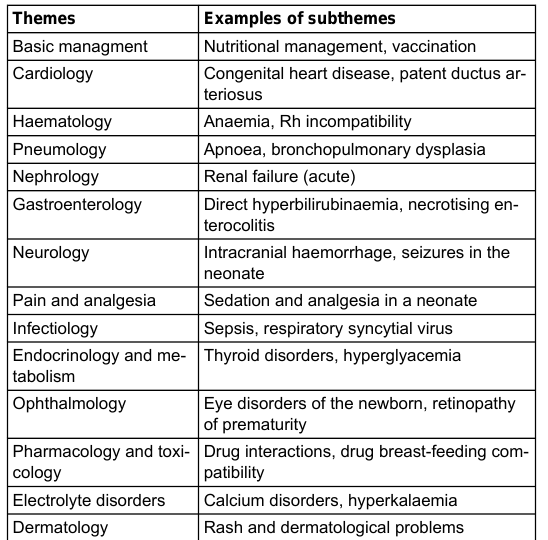
Table 2: Themes included in the literature